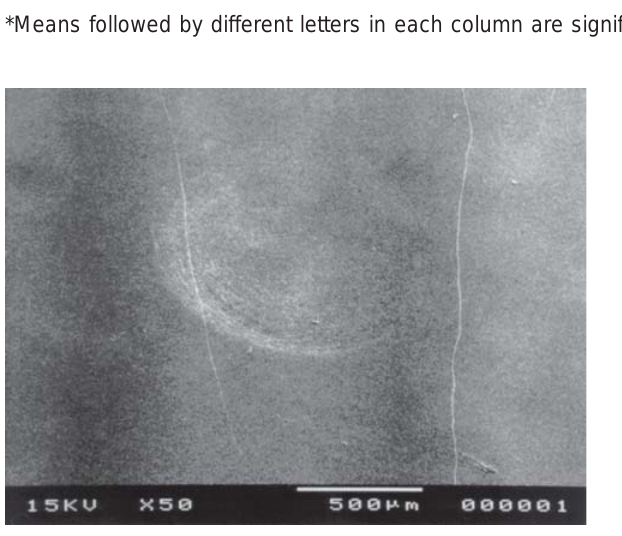
*Means followed by different letters in each column are significantly different (p<0.05).